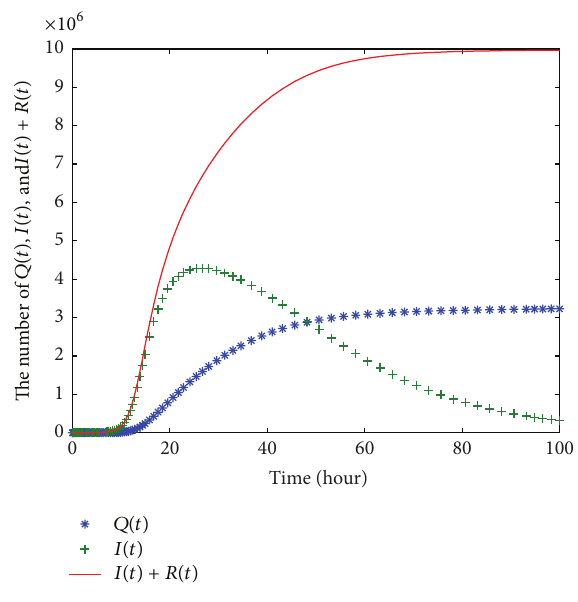
Figure 4: The simulation of TF